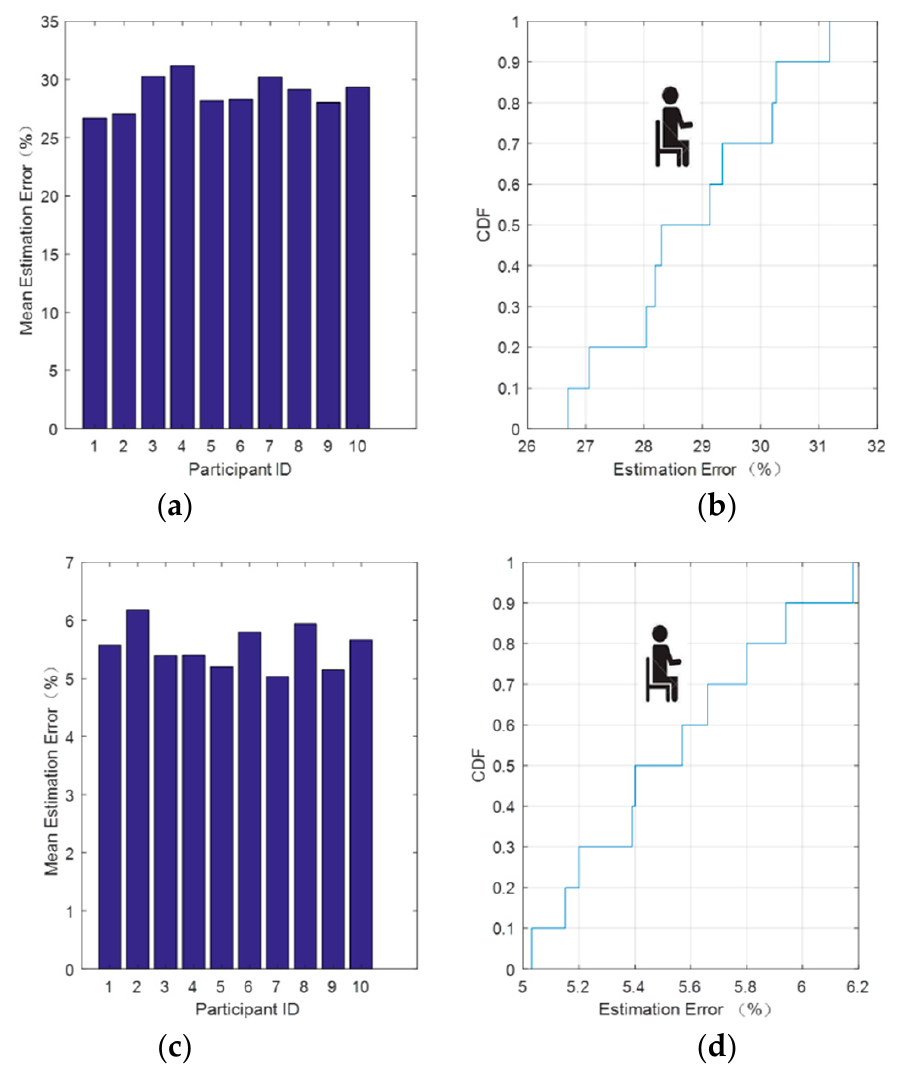
Figure 9. Respiratory signal relative error after data processing for the sitting posture. ( a ) Average error estimate and ( b ) CDF of the estimated error after soft threshold denoising. ( c ) Average error estimate and ( d ) CDF of the estimated error after hard threshold denoising.